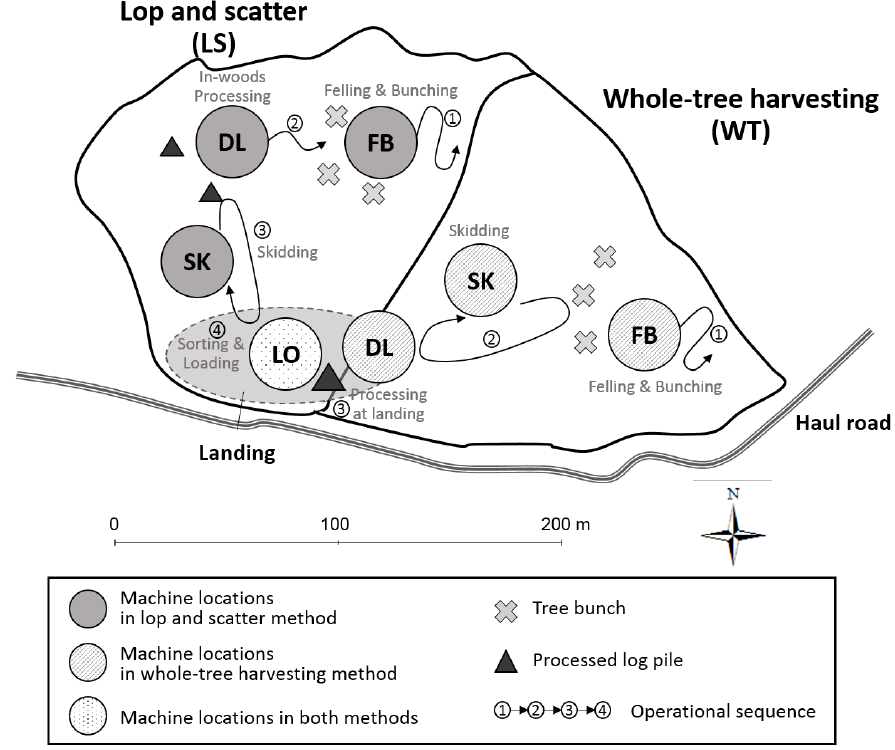
Figure 2. Harvesting equipment and operational sequence used in lop and scatter and whole-tree harvesting methods. Harvesting equipment includes feller ‒ buncher (FB), delimber (DL), skidder (SK), and loader (LO).